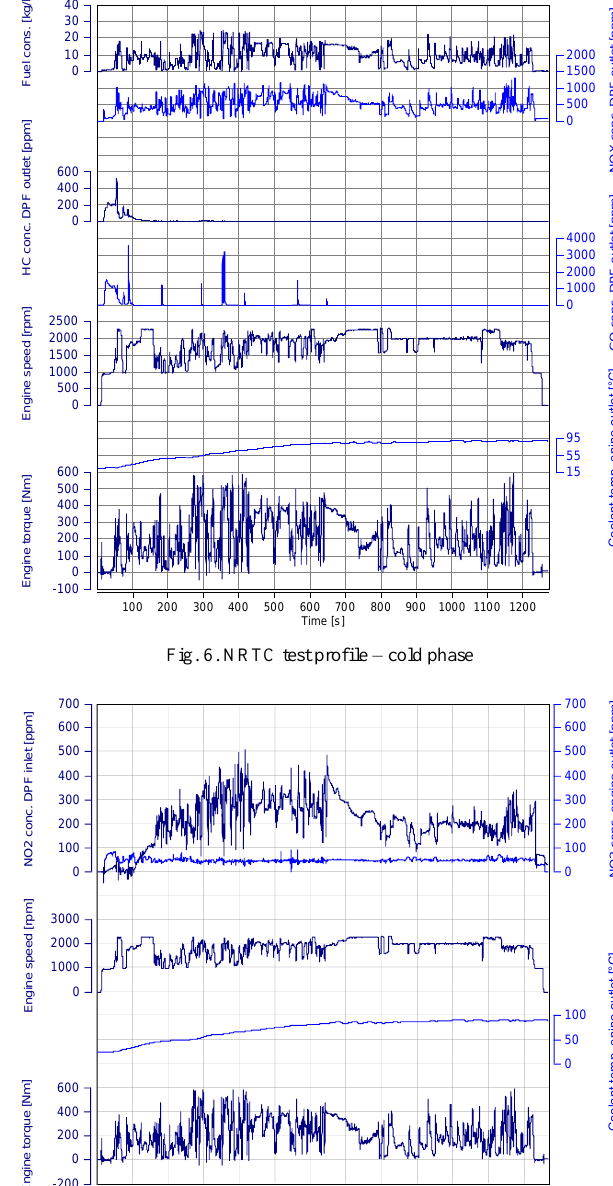
Fig. 7. NO 2 concentrations measured during the NRTC cold cycle The engine outlet NO values oscillated around 40–70 2 ppm, whereas downstream of the DOC (DPF inlet), the NO reached a level of 100–500 ppm, depending on the 2 engine operating point. An exception was noted during the first 130s of the test run, in which the engine outlet NO 2 level is greater than the DPF inlet one. Such behavior can be observed until the converter’s light-off temperature is reached. The presence of NO in exhaust gas is key for 2 effective execution of passive regeneration. To assess the magnitude of DPF loading under transient operating condi- tions, continuous measurement of the soot concentration at the engine-out position was carried